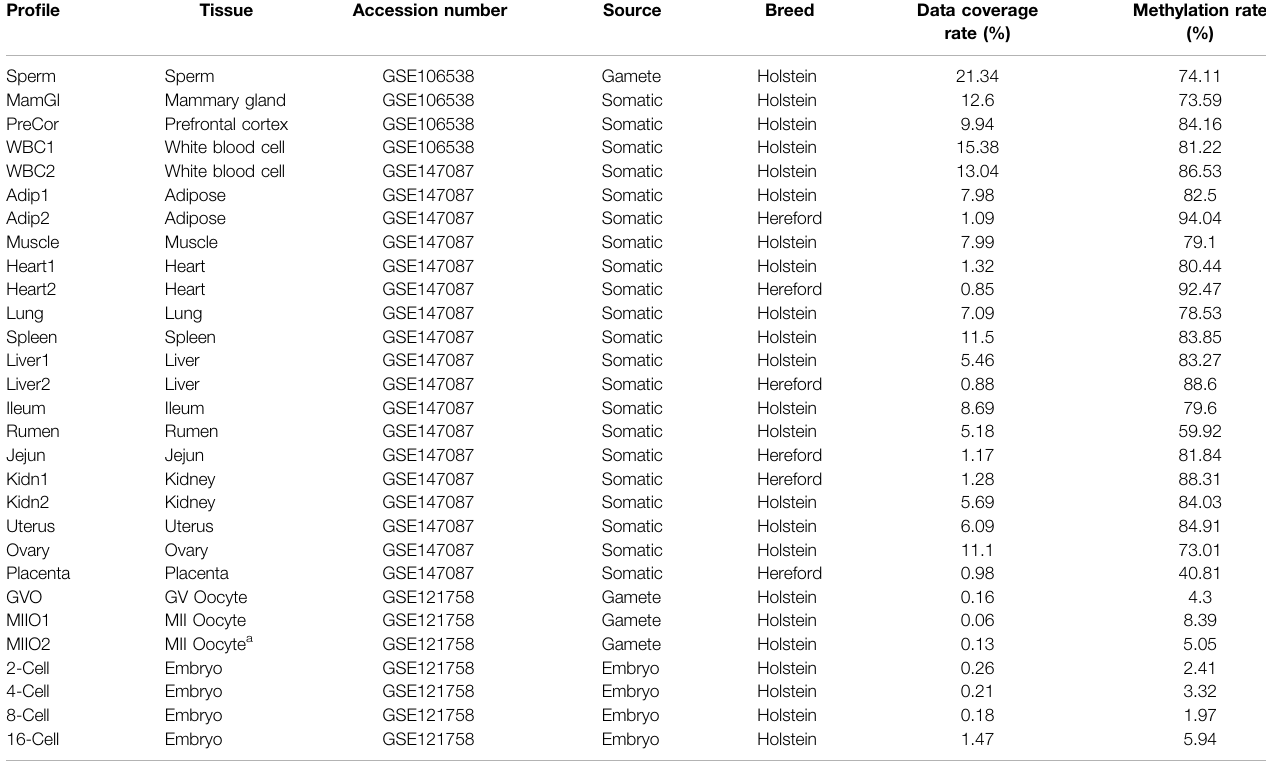
TABLE 1 | Summary of used bovine WGBS pro fi les. Pro fi